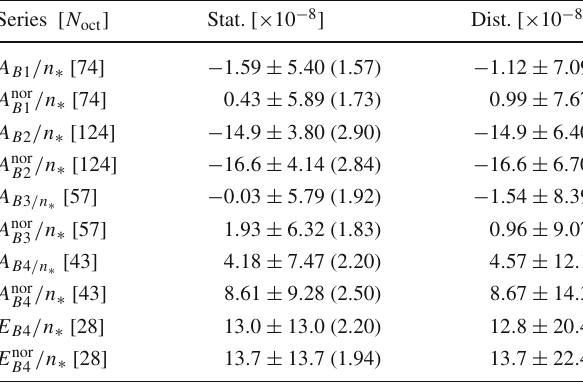
Table 1 Results for D B and (cid:14) B obtained from the average values of A B and E B measured in respective experimental cycles (in square brackets the amount of measurement octets in each cycle) taking into account only statistical errors (in parenthesis the quality of constant fit ( χ 2 / d . o . f .) is shown). Last column shows the mean values and variance